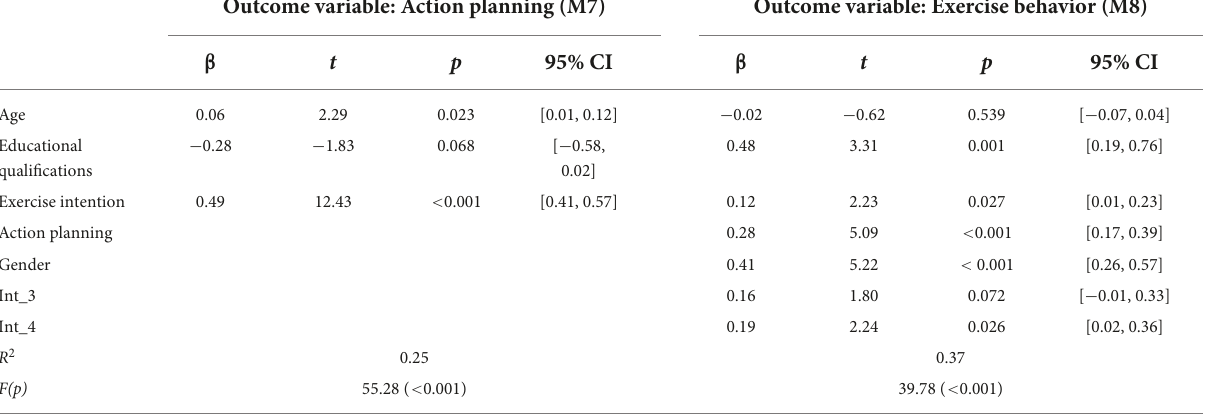
TABLE 6 Results of the test for moderating effects of gender.